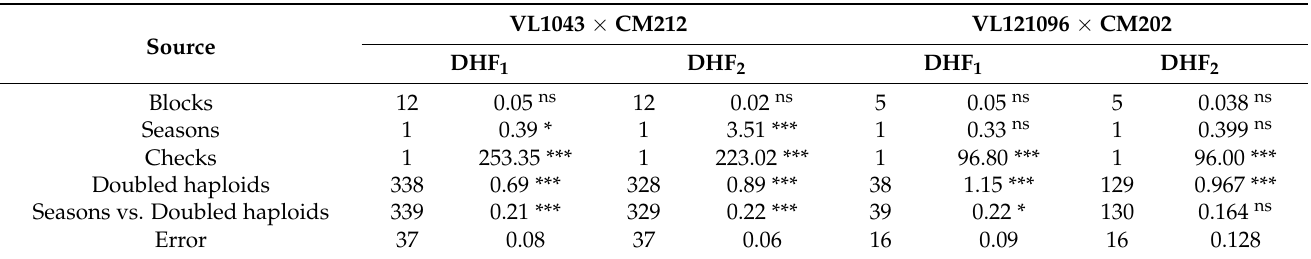
Table 3. ANOVA of mean FSR disease scores of DHF 1 and DHF 2 plants induced from the